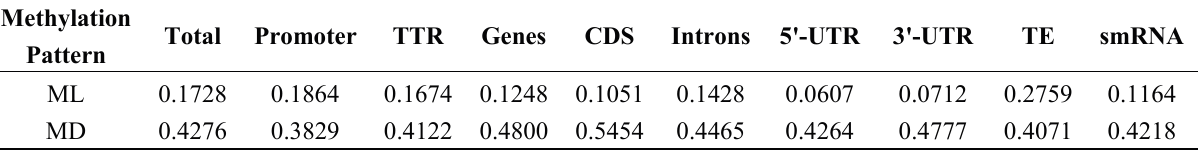
Table 2. DNA methylation patterns in different genomic regions.